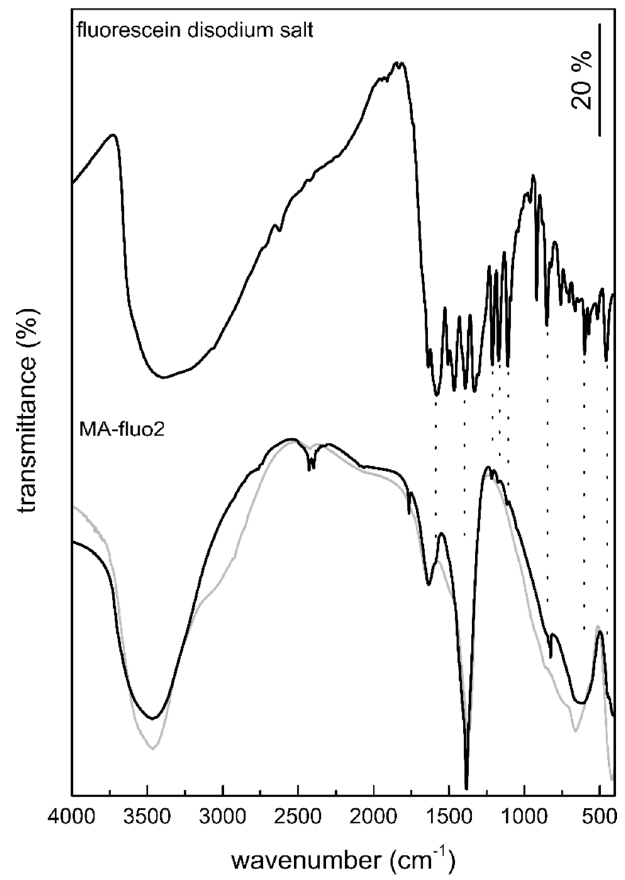
Figure 3. FTIR spectra of the fluorescein disodium salt (top) and sample MA-fluo2. The spectrum of a MA-CO 3 reference sample is included as a grey line. Dotted lines indicate absorption bands caused by vibrations in the divalent fluorescein anion.